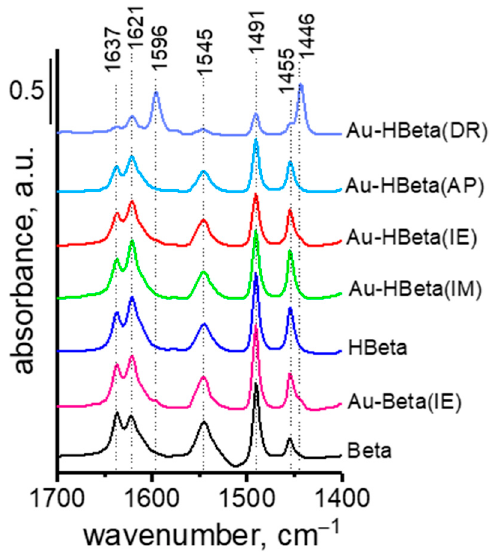
Figure 7. FTIR spectra after desorption of pyridine at 200 °C. All the spectra were obtained by subtraction the spectrum after activation and normalized to the density of a wafer of 10 mg·cm − 2 .